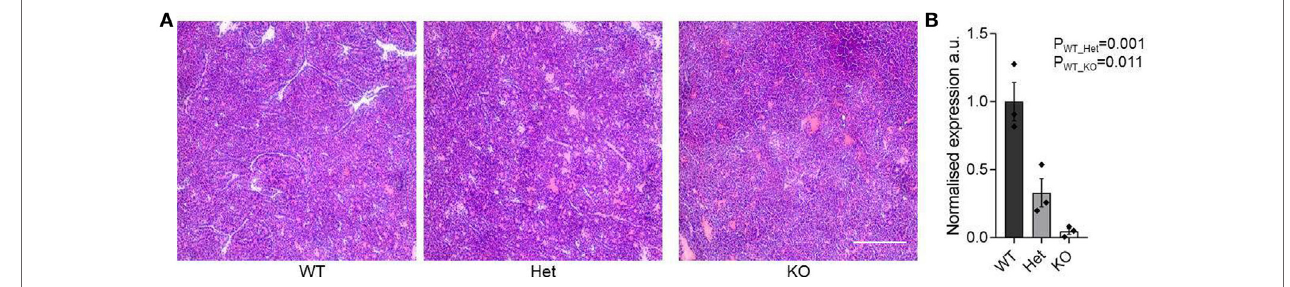
FigUre 1 | Pancreatic acinar carcinoma development in miR-342 knockout mice . Pancreatic tumors were dissected from TAg + , miR-342 + /0 TAg + , and miR-342 0/0 TAg + mice at 21 weeks of age. (a) Representative histology of tumors from each genotype. Scale = 250 μ m. (B) Expression of miR-342 in tumors from wild-type, heterozygous, and KO mice ( n = 3/group). Individual values shown with mean and standard error.